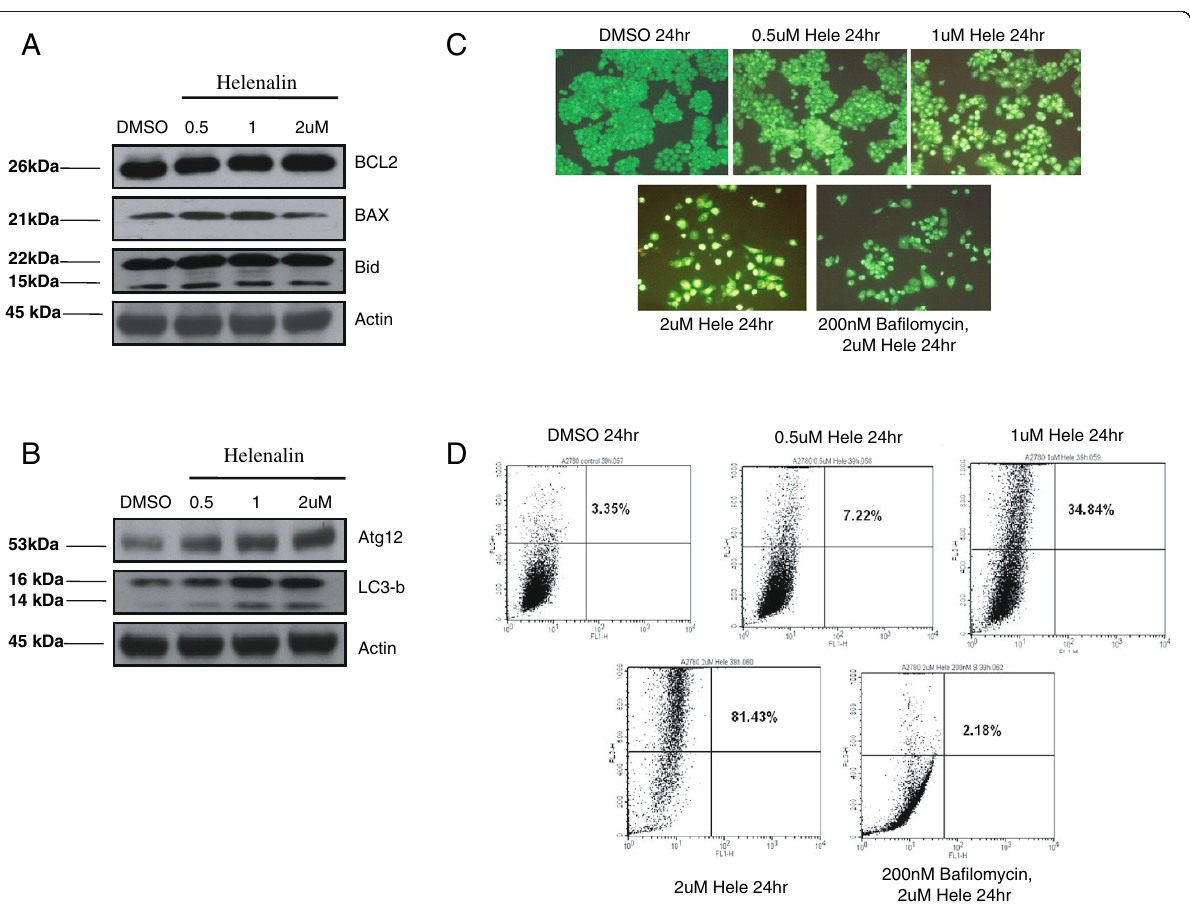
Figure 5 Helenalin induces autophagy cell death. A2750 cells were treated with increasing concentrations of helenalin for 24 h, following which cells were harvested and cell lysates prepared and subjected to immunoblot analysis for ( A ) BCL2, BAX and Bid or ( B ) Atg12 and LC3-B. Actin was used as the loading control. A2750 cells were treated with DMSO, 0.5uM, 1uM, 2uM helenalin or pretreated with 200nM bafilomycin A1 for 45 min before treatment with 2uM helenalin for 24 h. Following which, cells were stained with Acridine Orange Solution and photographed using a florescence microscope (positive AVO staining in red) ( C ) or ( D ) trypsinized and harvested for FACS analysis to quantitate levels of cell staining representing autophagy. Figures represent data from three independent